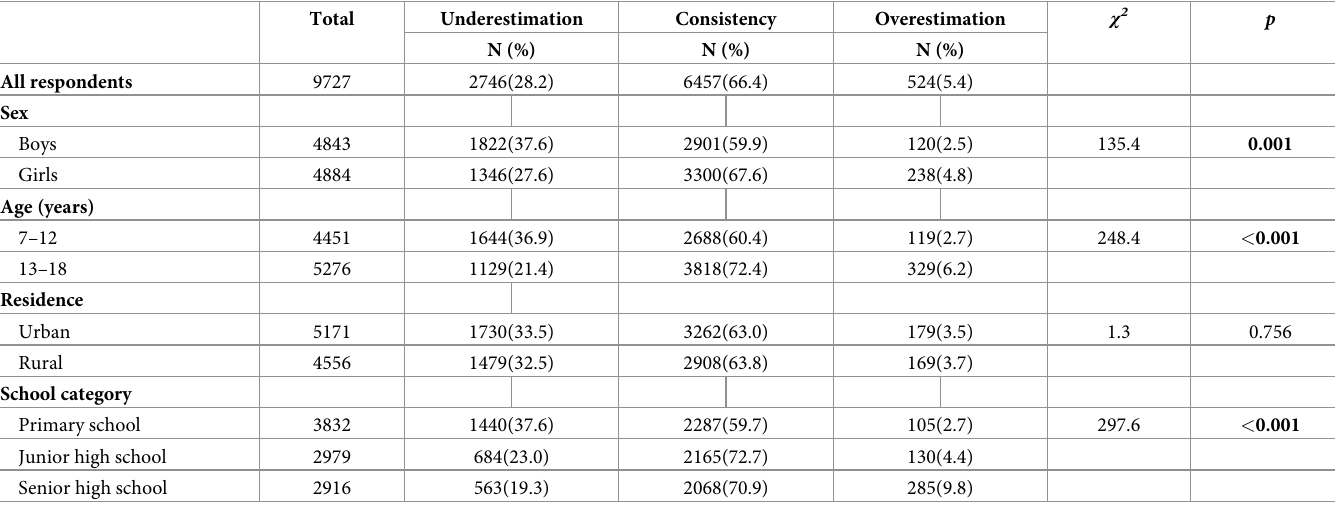
Table 3. Consistency of BMI and body weight perception by sex, age, residence, and school category a . Total Underestimation